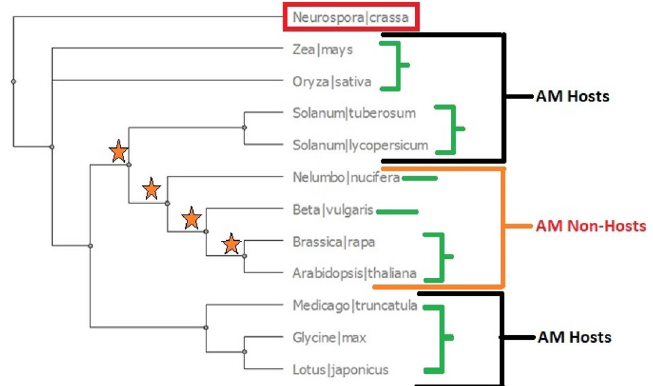
Figure 5. Species tree for selected host and non-host genomes. Green brackets represent host and non- host family clusters. Black brackets and Orange brackets are representative of Host and non-host species respectively. Red box represents the outgroup while orange asterisk signifies the event that lead to non-host lineage emergence. All non-host species emerge from one speciation event and further diverge depending on the environmental conditions. This tree served as a blue print to understand whether a gene is affected by plant speciation or has an independent process of experiencing evolutionary constraints when correlated with the gene